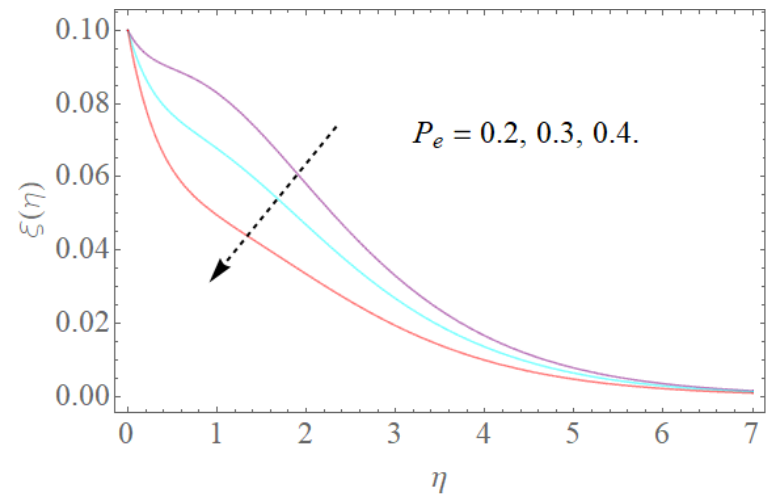
Figure 16. The effect of P e on ξ ( η ) when L b = 1.5, σ 1 = 0.5.